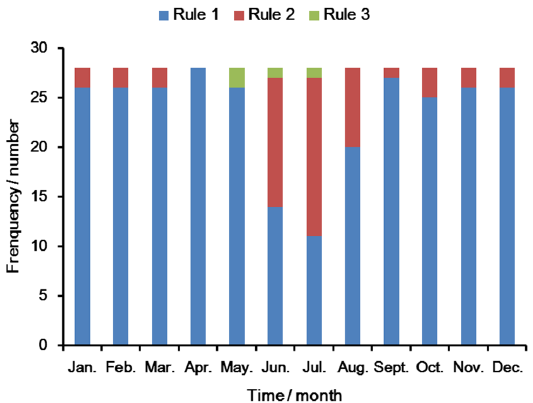
Figure 11. The triggering frequencies of the three hedging sub-rules of the proposed rule for each month during the 28 years from 1973 to 2000.